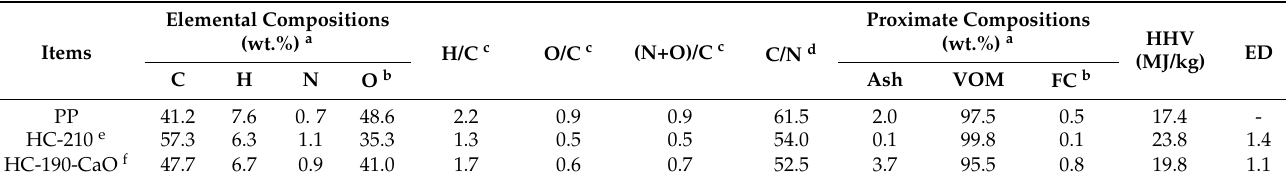
Table 1. Proximate/elemental compositions of raw PP and HC